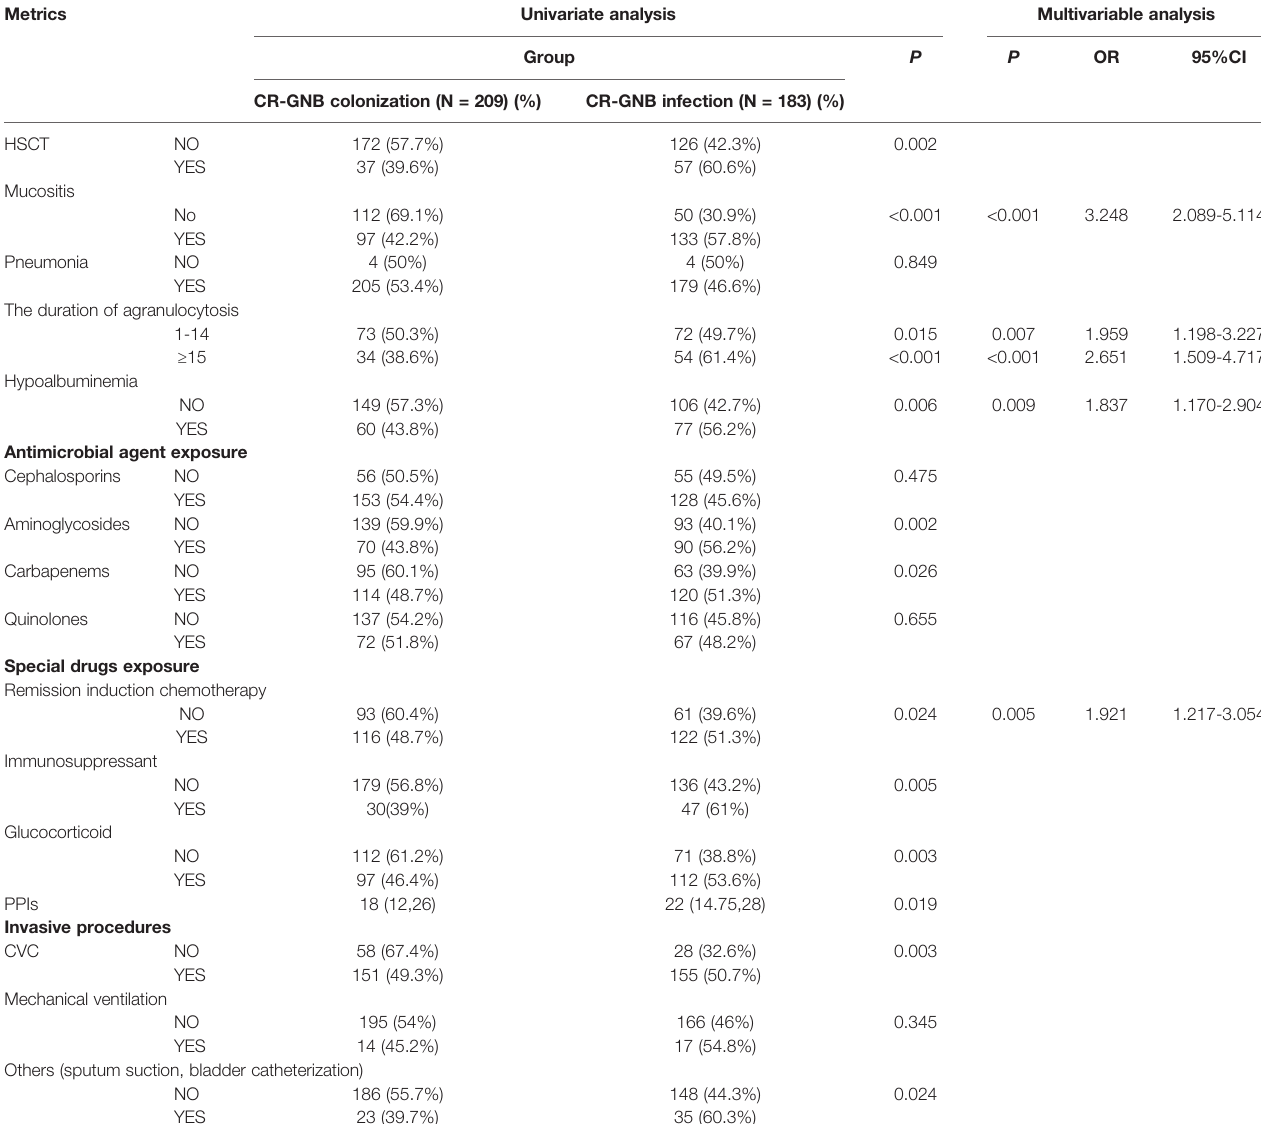
TABLE 2 | Risk factors of subsequent infection after CR-GNB colonization in HM patients.